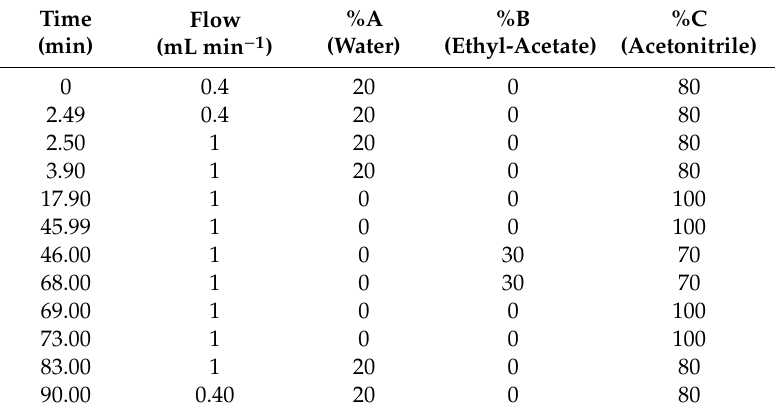
Table 1. Gradient program for the separation of